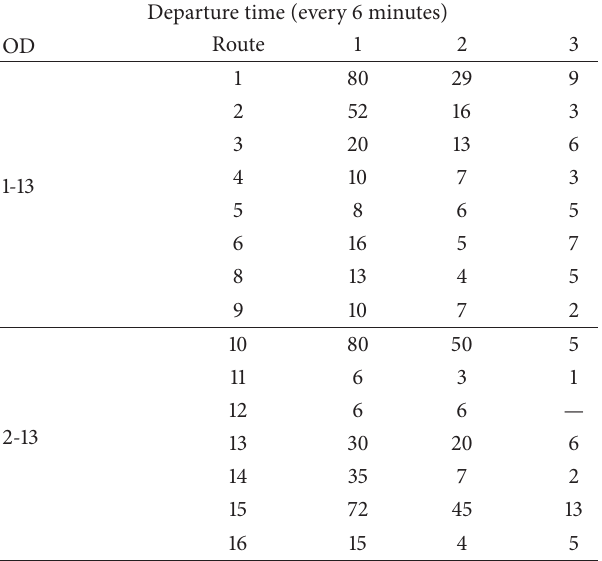
Table 5: Optimal evacuation planning ( 𝐷 1,13 = 300, 𝐷 2,13 =